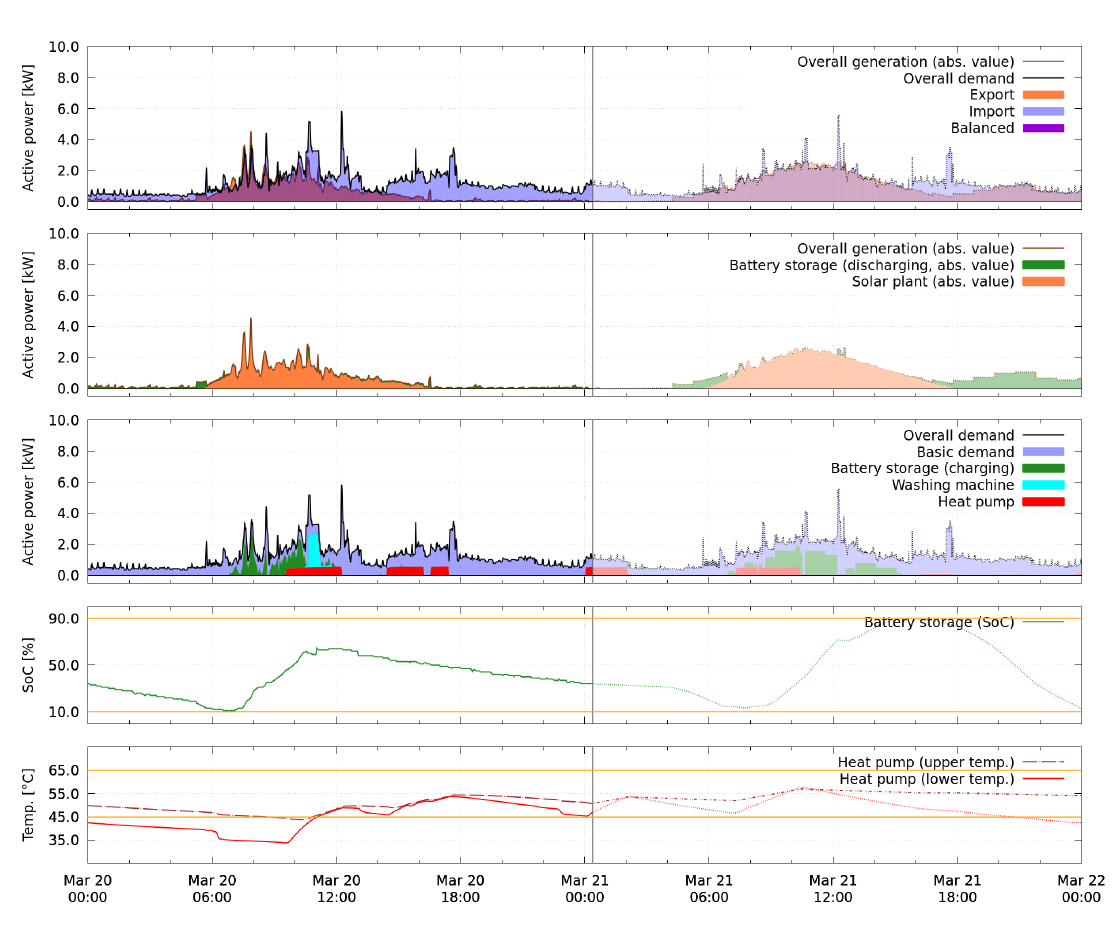
Figure 15. Experimental results from the demonstration site for 20 March: measured history until shortly after midnight and planned schedules for the following 24